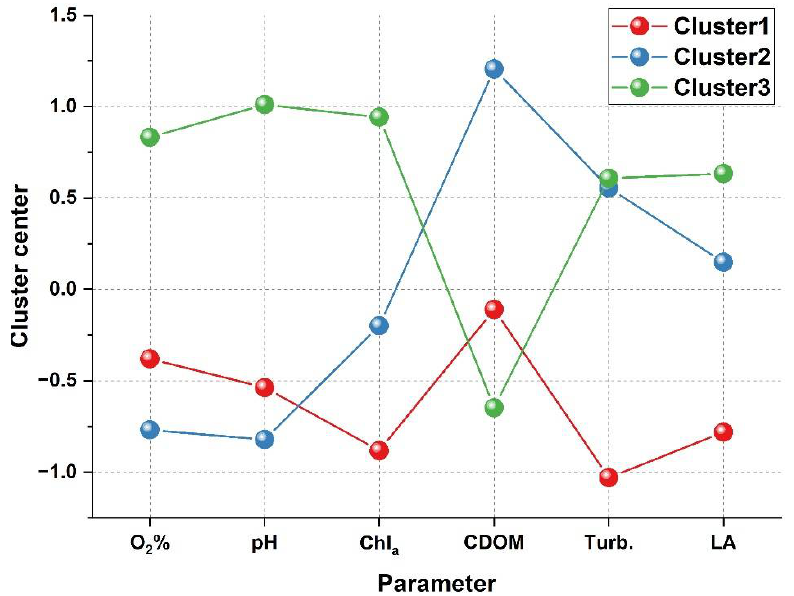
Figure 8. Plot of standardized cluster centers obtained from k-means clustering performed on BIOFISH parameters. A value of 0 corresponds to mean concentration and a value of 1 to standard deviation. The cluster centers indicate characteristic values of each cluster.